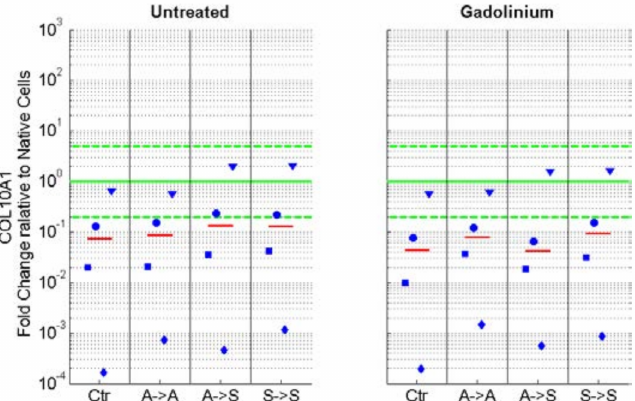
Figure 5. mRNA expression of collagen type X ( COL10 ), normalized to the gene expression of native cells. Collagen type X expression was generally downregulated in all conditions but showed great variability among the four animals. The blue markers indicate the individual values of the four unique animals (unique shape for each animal), and the red line indicates the median from all experiments. The green horizontal lines indicate the one-fold (no change; solid line) and five-fold upregulation and downregulation (dashed lines), respectively. The nomenclature of the samples is indicated in Figure 1. The addition of 20 mM gadolinium to the culture medium resulted in a higher COL2 / COL1 and ACAN / VCAN expression when compared with the untreated cells (Figure 6) but did not influence the expression of collagen type X (Figure